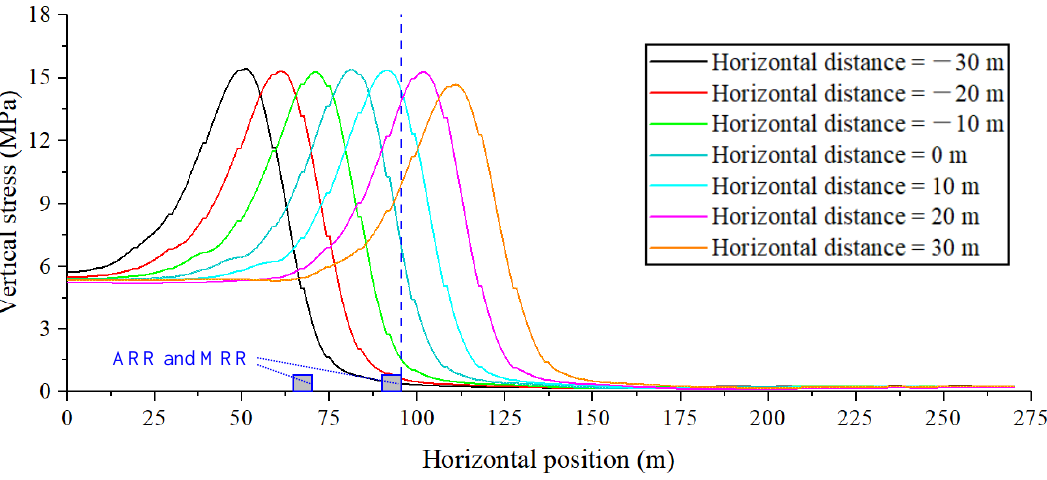
Figure 6. Distribution of immediate roof stress at different horizontal distances.